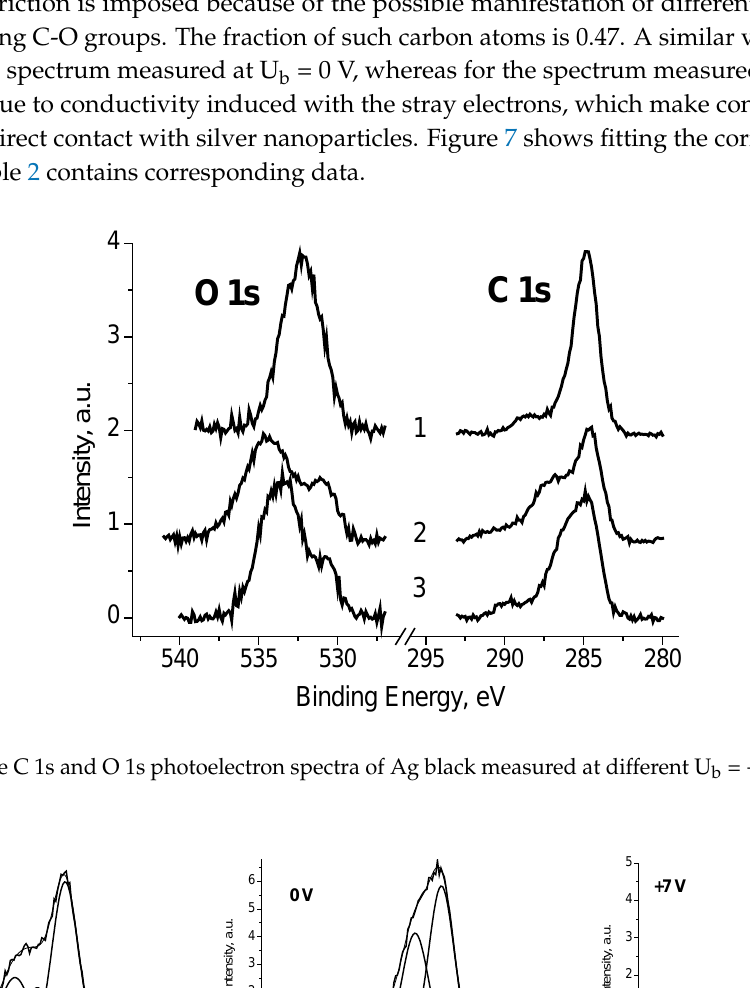
Figure 7. Fitting the C 1s photoelectron spectra of Ag black measured at U b = − 7, 0 and 7 V. Table 2. Binding energies (E b ), peak widths (W) and relative intensities of the peaks deconvoluted in the C 1s and O 1s spectra of Ag